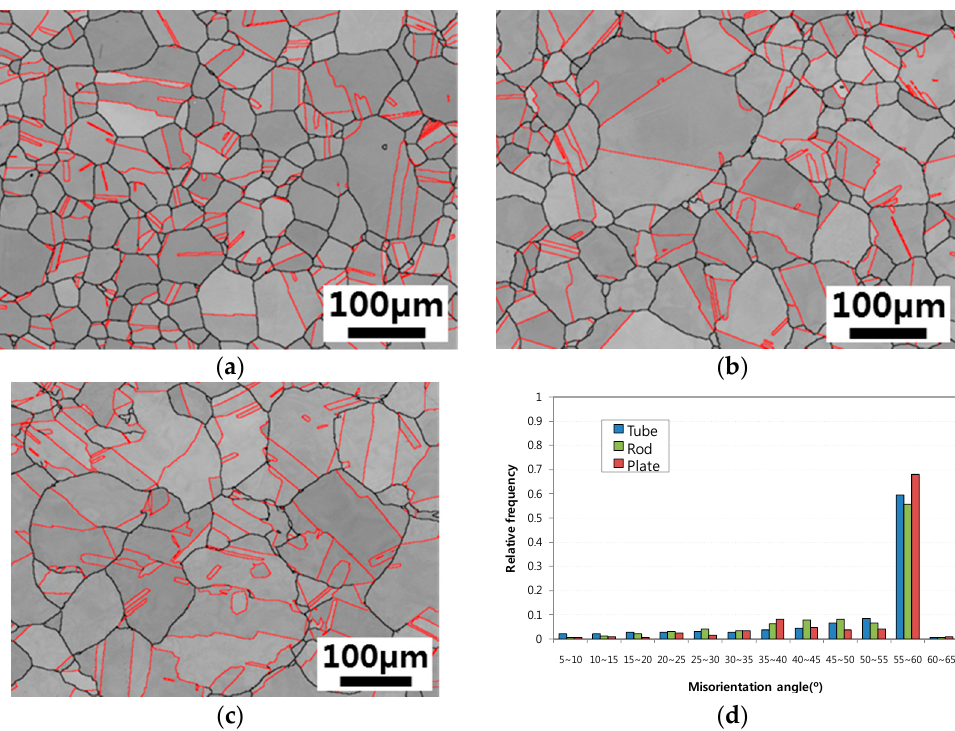
Figure 6. Grain boundary character analysis using EBSD where random boundaries are in black and twin boundaries are in red line: ( a ) Tube; ( b ) Rod; ( c ) Plate; ( d ) Grain boundary angle distribution plot. Table 6. Fraction (%) for some important grain boundary